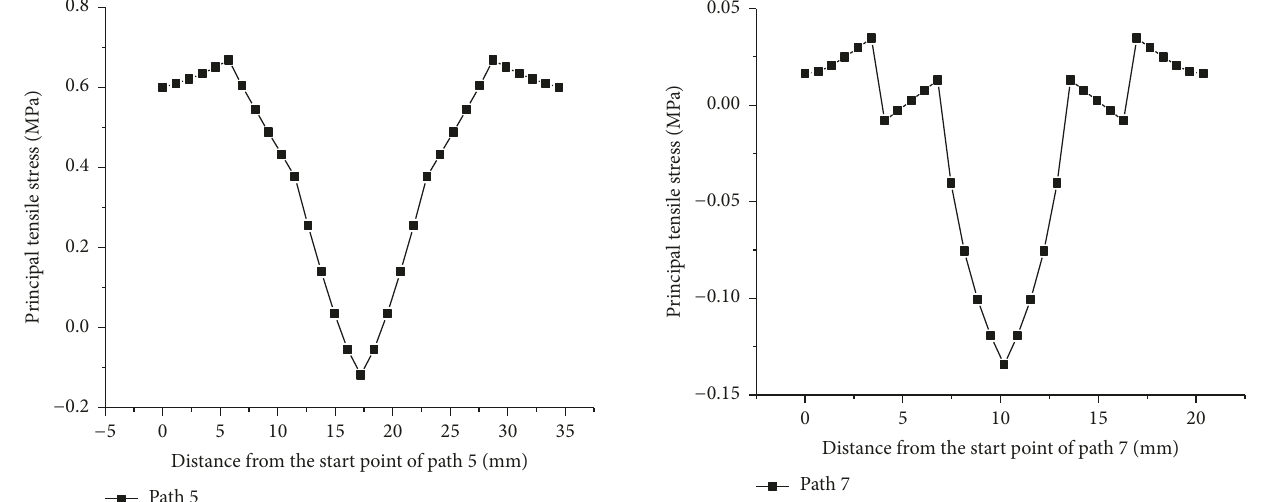
Figure 37: Principal tensile stress in the concrete specimen pre- stressed under a load of 10MPa when the displacement resulting from corrosion-induced expansion reaches 0.031 mm.